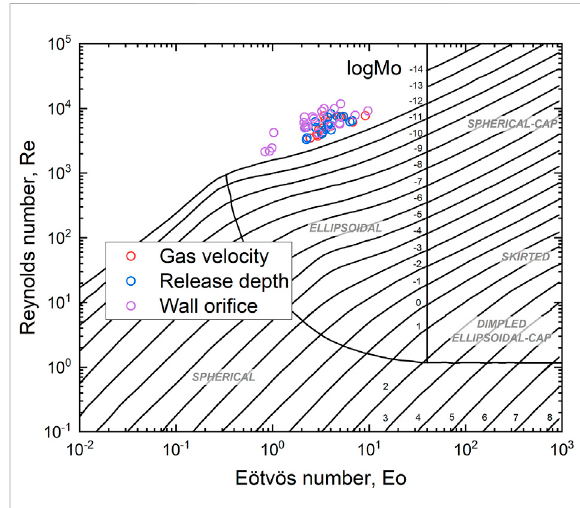
FIGURE 13 Simulation results on Grace ’ s graphical empirical